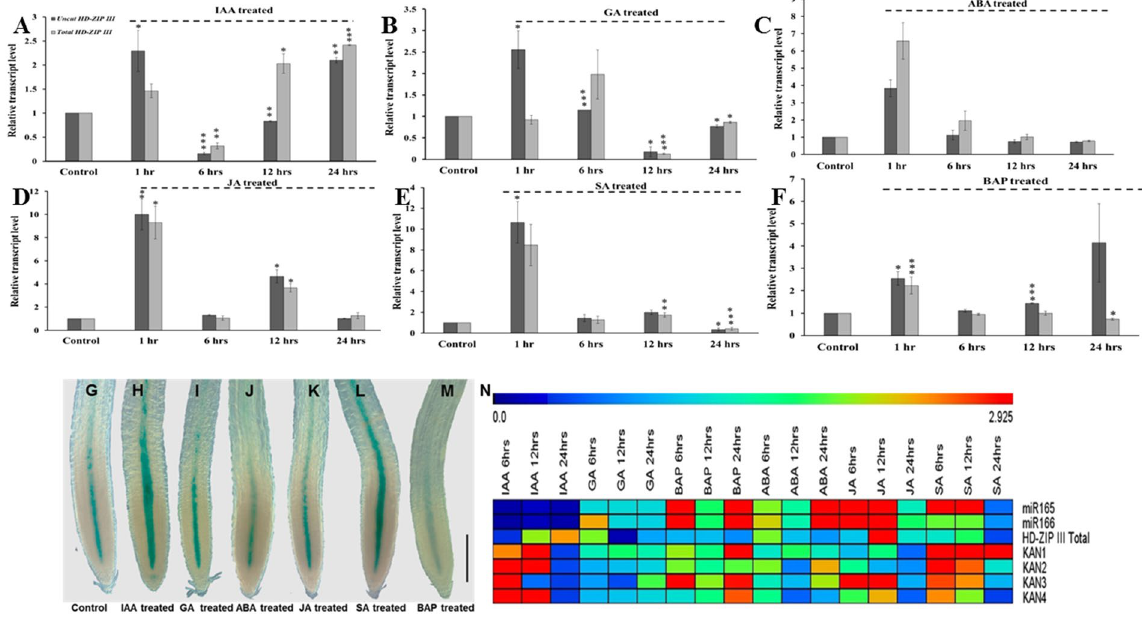
Figure 5. Phytohormones affect the expression level of HD-ZIP IIIs transcript level. The expression of total HD- ZIP IIIs at 1, 6, 12 and 24 hrs of the treatment of ( A ) 10 µ M IAA, ( B ) 10 µ M GA, ( C ) 10 µ M ABA, ( D ) 20 µ M JA, ( E ) 100 µ M SA and ( F ) 10 µ M BAP. The control indicates untreated roots in each case. Error bars indicate ± SE of two independent biological experiments. One-way ANOVA was performed. Statistically significant differences are indicated as, * for P < 0.05, ** for P < 0.01 and *** for P < 0.001. ( G–M ) GUS expression analysis of pPHB::PHB-GUS roots after 12 hrs of the hormone treatment in ( G ) untreated control ( H ) 10 µ M IAA, ( I ) 10 µ M GA, ( J ) 10 µ M ABA, ( K ) 20 µ M JA, ( L ) 100 µ M SA, and ( M ) 10 µ M